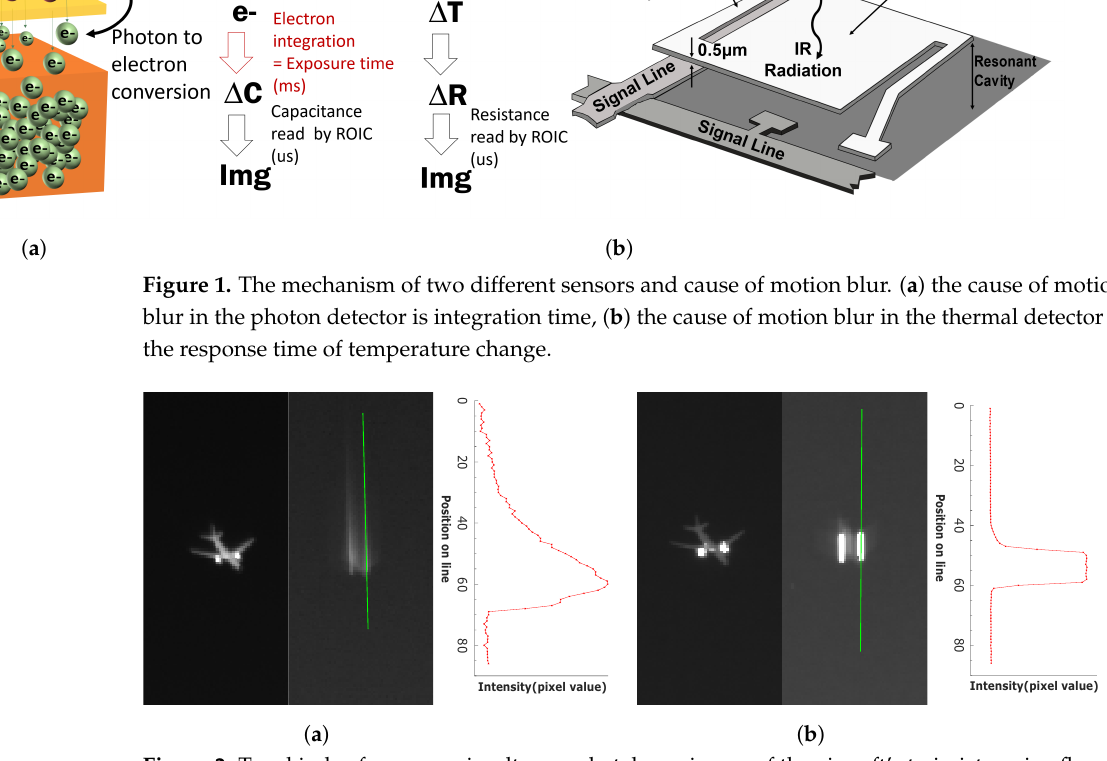
Figure 2. Two kinds of cameras simultaneously take an image of the aircraft’s twin-jet engine flames. Both images have motion blur, but they have different motion blur patterns. ( a ) LWIR camera using thermal detector, ( b ) MWIR camera using photon